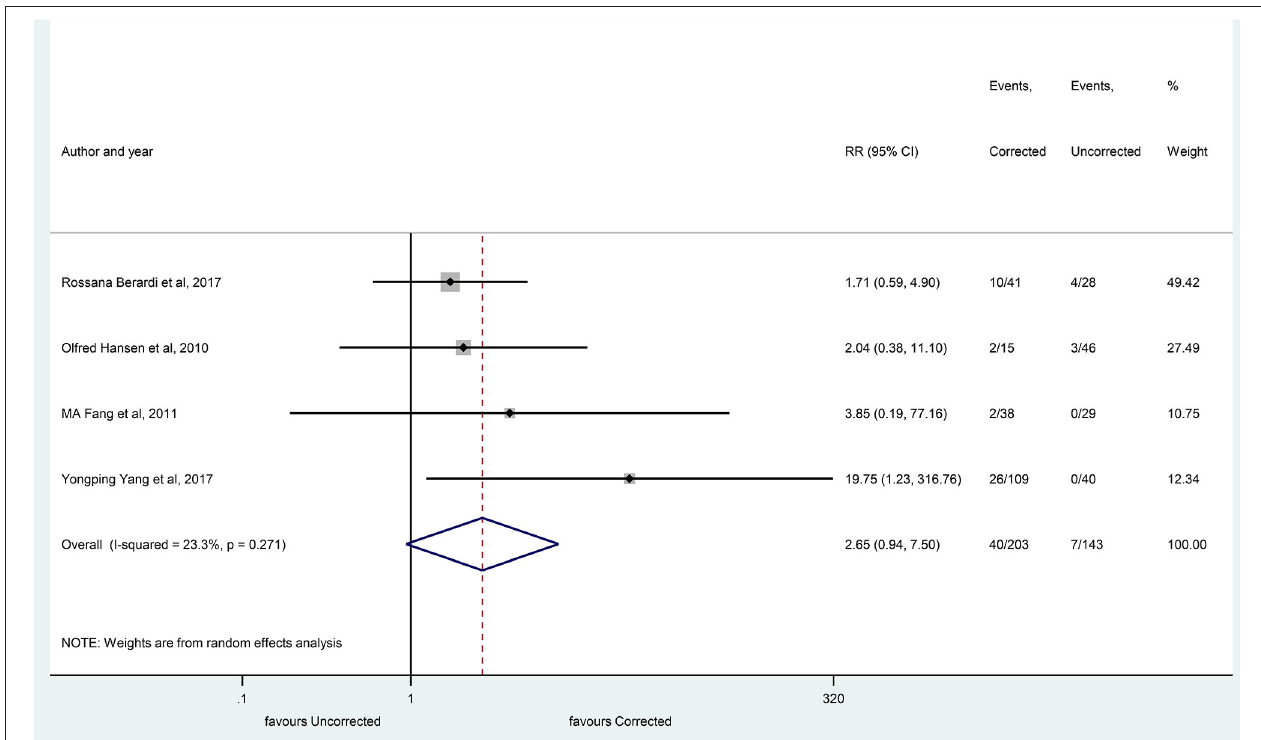
FIGURE 11 | The overall survival rates after correction of hyponatremia at 20 months (corrected and uncorrected hyponatremic patient groups). Black diamonds represent the individual effects of studies, and vertical lines show the corresponding 95% CI. The size of the gray squares reflects the individual weight of a particular study. The blue diamond shows the overall or summary effect. The outer edges of the diamonds represent the CIs. RR, risk